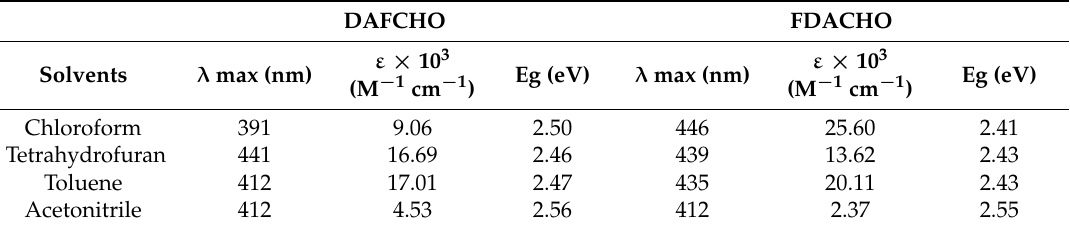
Figure 4. Absorption spectra: ( a ) DAFCHO (0.026 mol/mL); and ( b ) FDACHO (0.030 mol/mL) in different solvents. Table 1. Optical properties of DAFCHO and FDACHO in different solvents.